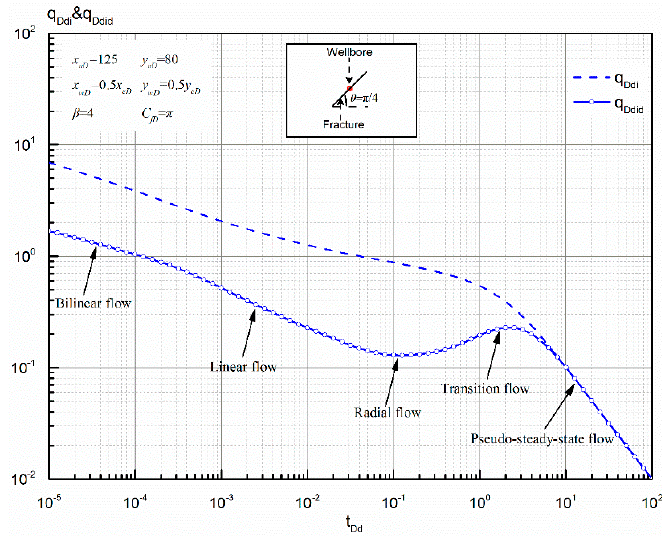
Figure 12. Flow regimes on Blasingame format curves for a well penetrated by a fracture with an azimuth angle in an anisotropic rectangular reservoir.